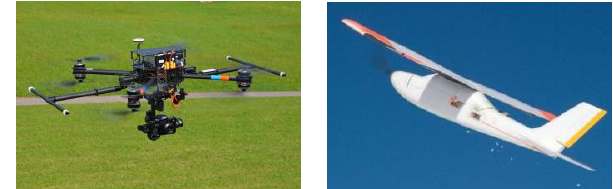
Figure 2. AustroDrones X18 (left – source: Austro Drones) and BFW Mentor (right)